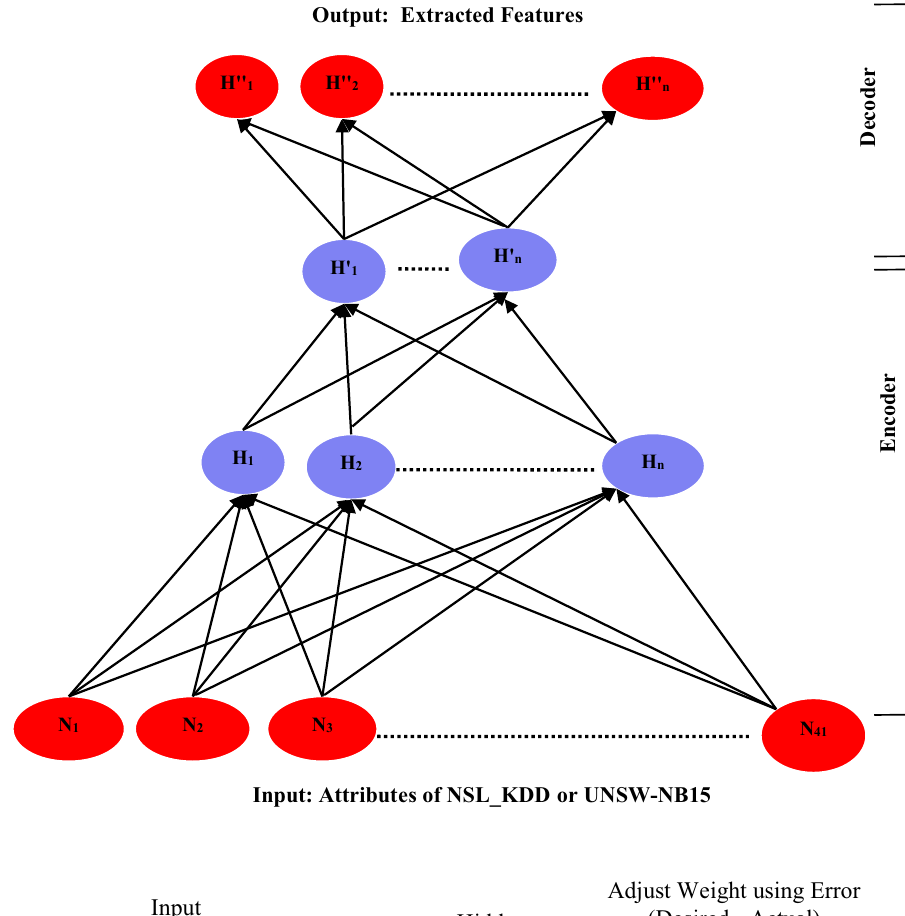
Fig. 4 Feature extraction using deep autoencoder